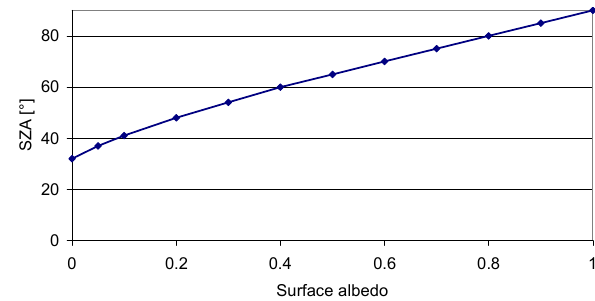
Figure 19. SZA, for which the O 4 absorption becomes independent from the aerosol optical depth as function of the surface albedo (see also individual simulation results in Fig. A3 in the